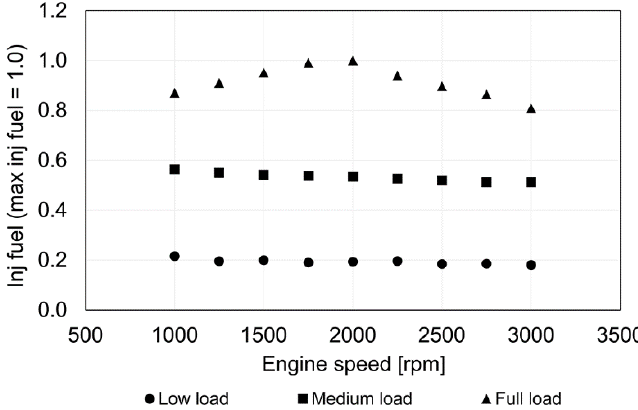
Figure 9. Injected fuel quantity at three load levels by varying the engine speeds from 1000 rpm to 3000 rpm (step of 250 rpm): data is normalized with respect to the maximum injected fuel quantity.